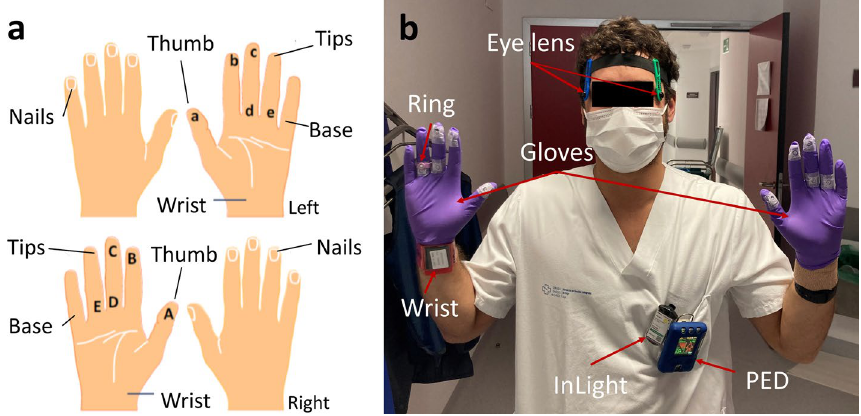
Fig. 2 Dosimeters used for staff monitoring: a TLD positioning in the hands, b all the dosimeters used for extremity, eye lens and whole‑body